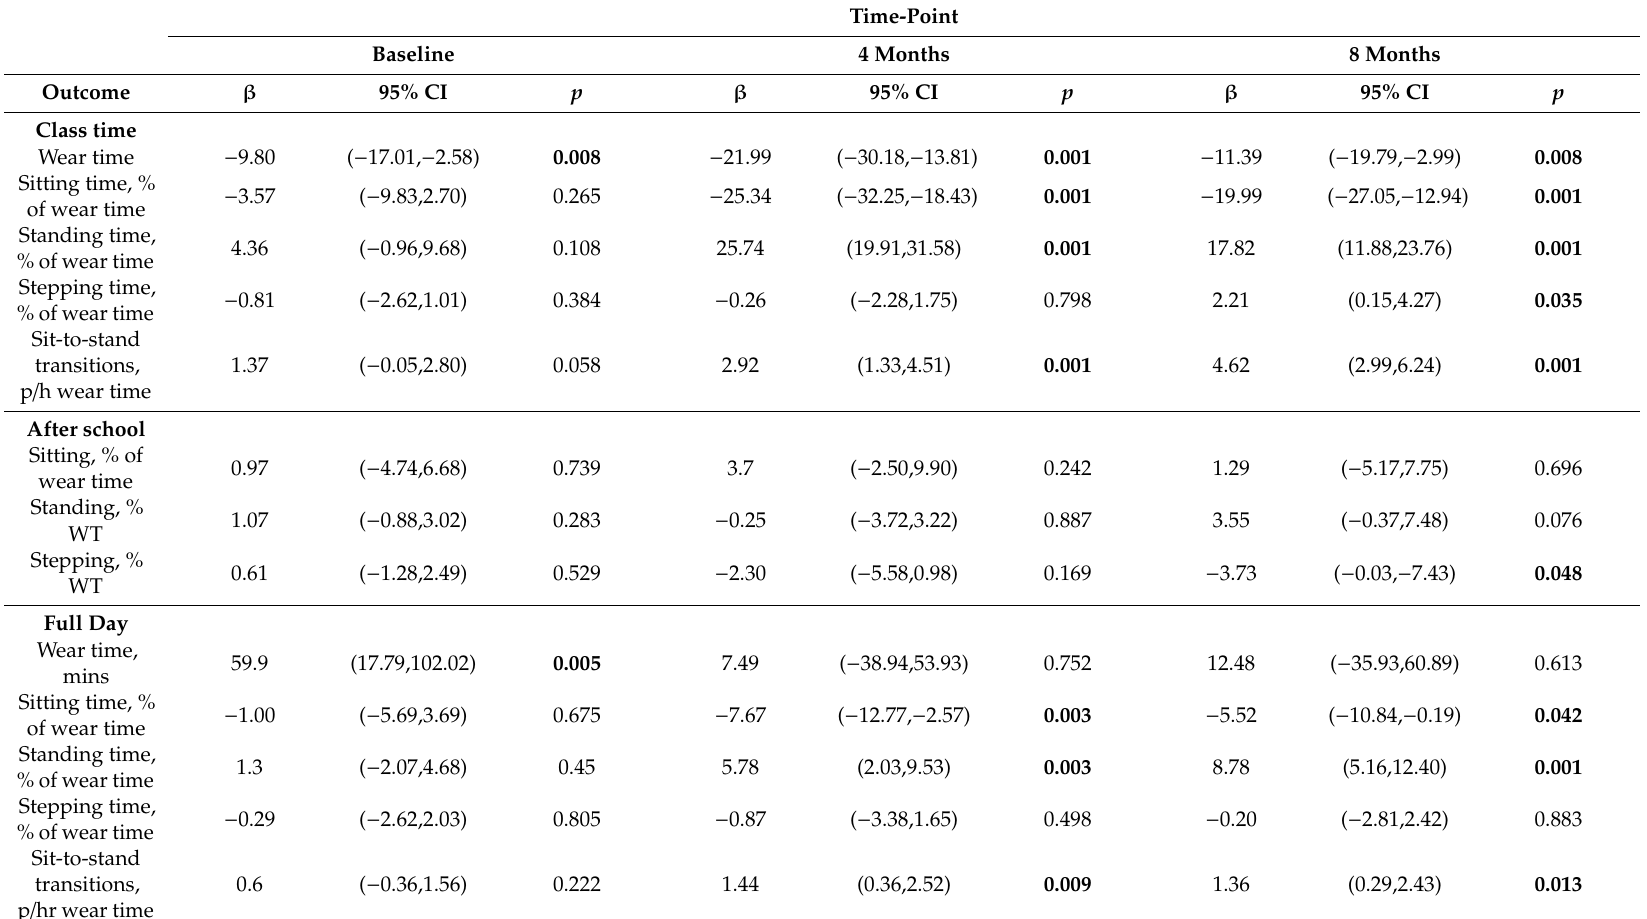
Table 3. Estimated e ff ect sizes of the intervention in activPAL-determined outcomes during class time, after school and full weekdays at baseline, 4 months, and 8 months from multi-level